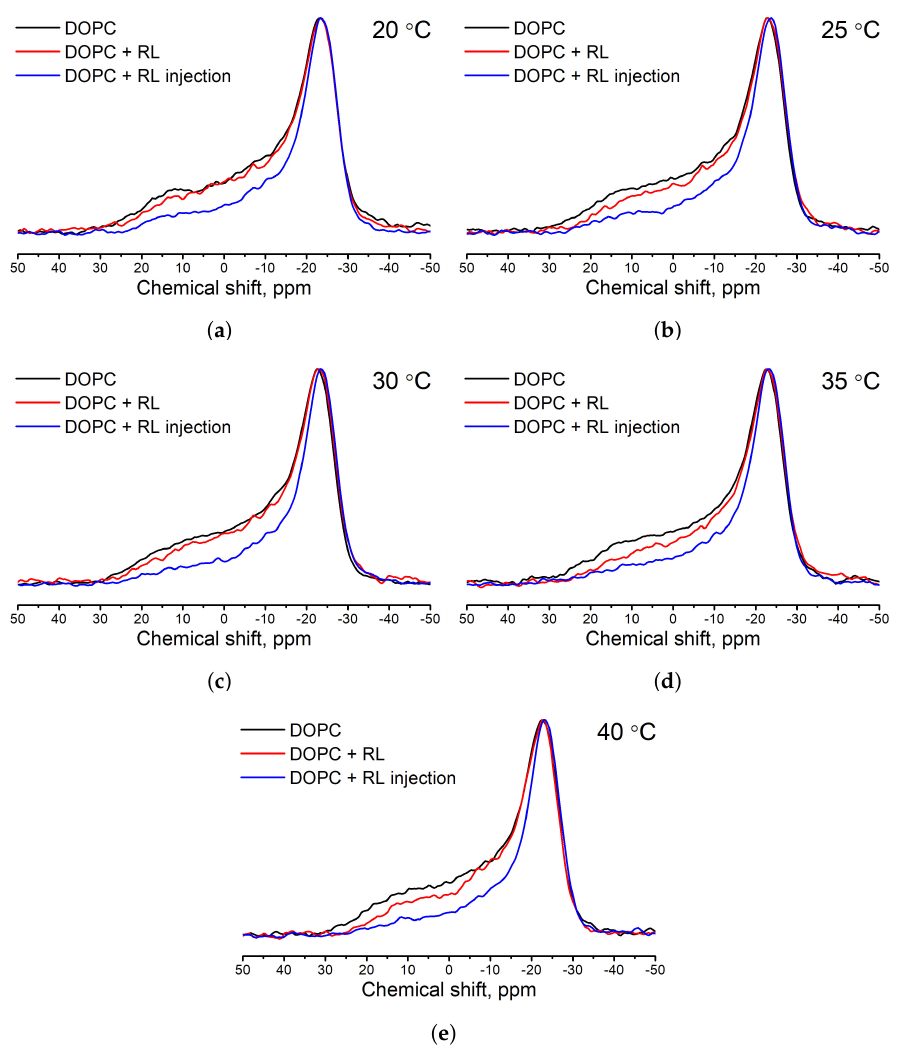
Figure 2. 31 P NMR spectra of liposomes from DOPC (black solid line), liposomes from DOPC and rhamnolipids (red solid line), and liposomes from DOPC with rhamnolipid injection (blue solid line) at different temperatures ( a – e